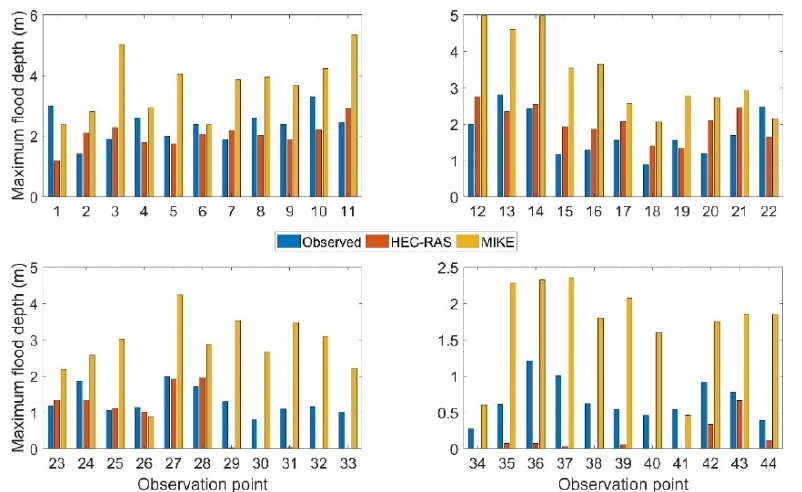
Figure 12. Comparison of the maximum flood depths derived by field observations: HEC-RAS simulation and MIKE FLOOD simulation.